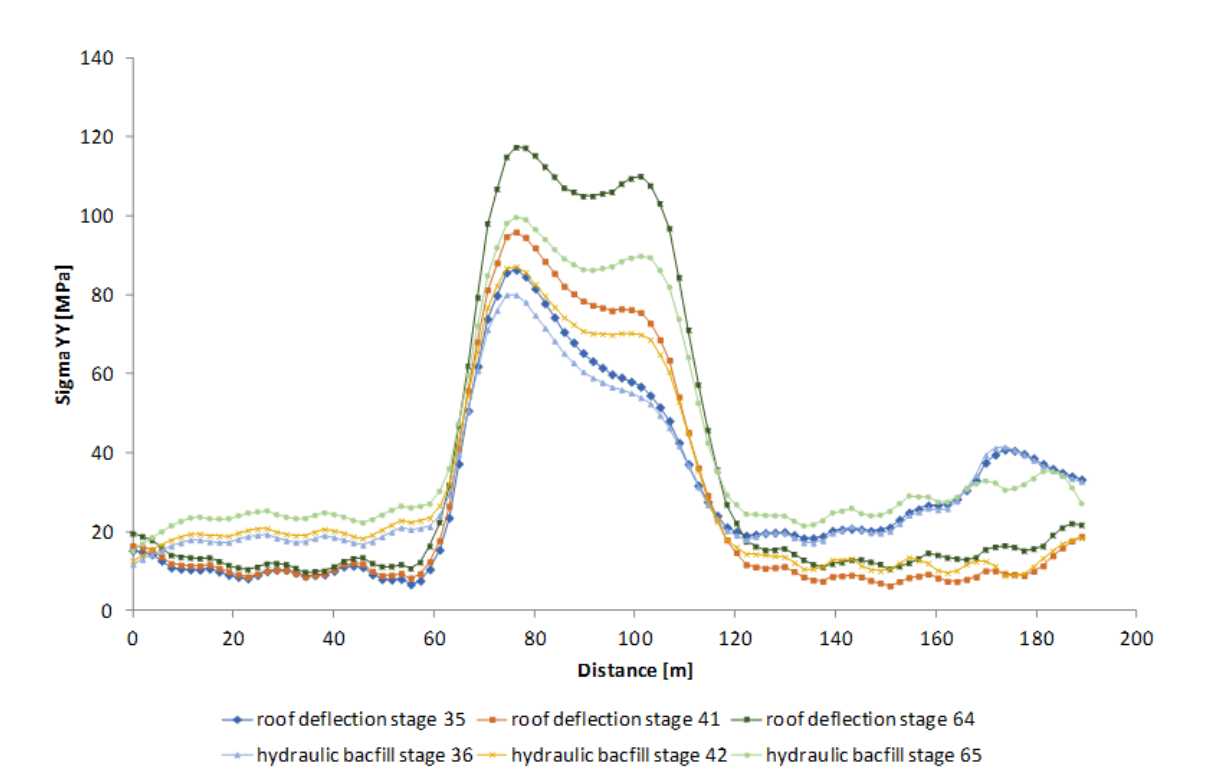
Figure 13. Vertical stress σ y in the roof, for vertical distances of: ( a ) — 5 m, ( b ) — 10 m, ( c ) — 20 m and ( d ) — 40 m above the remnant.